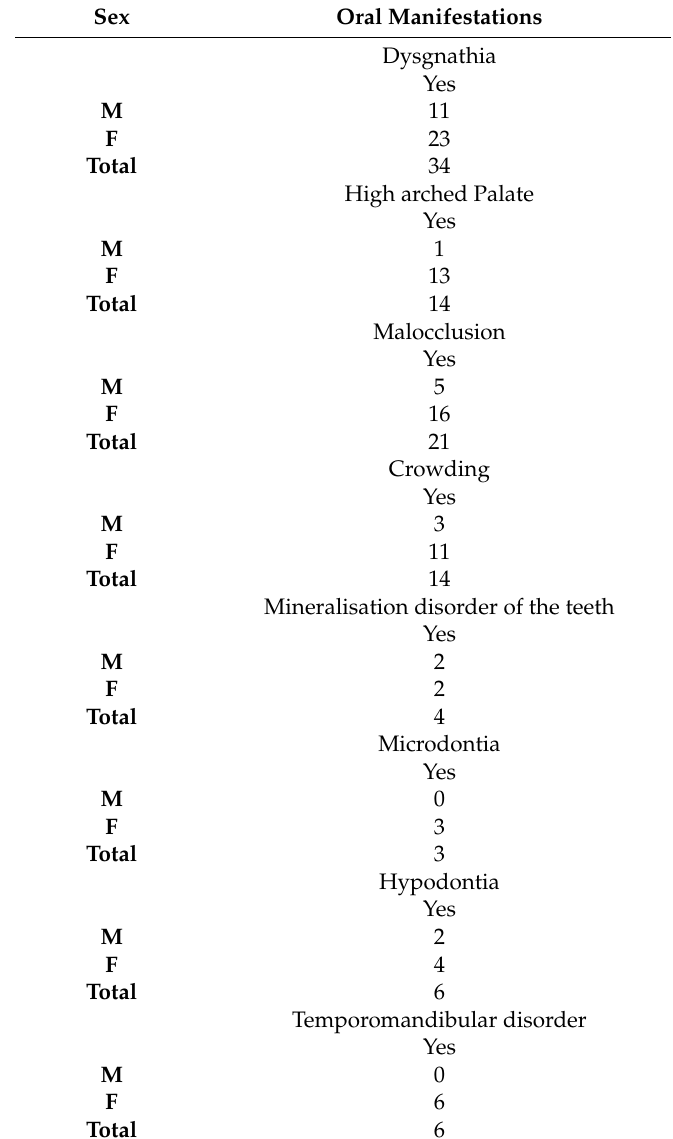
Table 2. Main oral manifestations according to gender. M = Male; F =